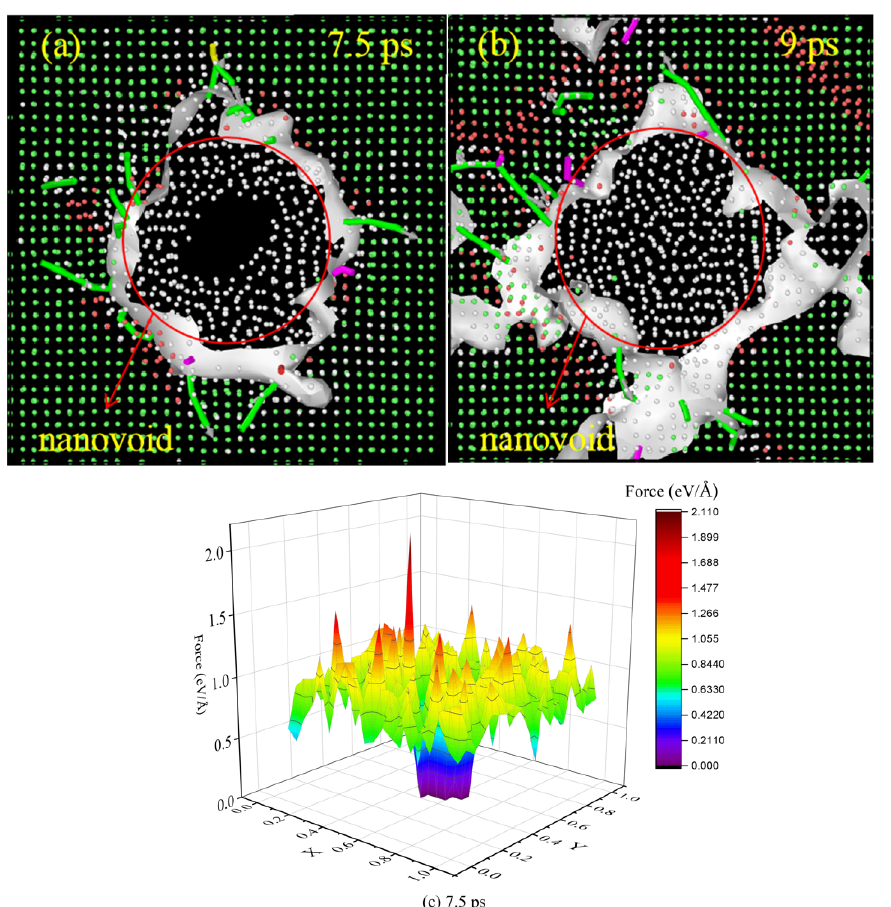
Figure 5. Snapshots of dislocation lines at time instants of ( a ) t = 7.5 ps and ( b ) t = 9 ps around nanovoid (r = 1.45 nm) under shock compression along the [001] crystal orientation ( z direction) with a shock wave of 5 km/s and ( c ) shows the atomic force diagram at 7.5 ps.